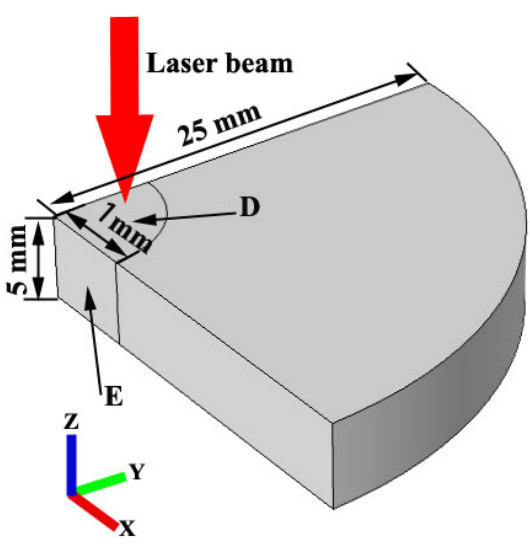
Table 1. Thermodynamic parameters of silicon at the wavelength of 3.8 µm.